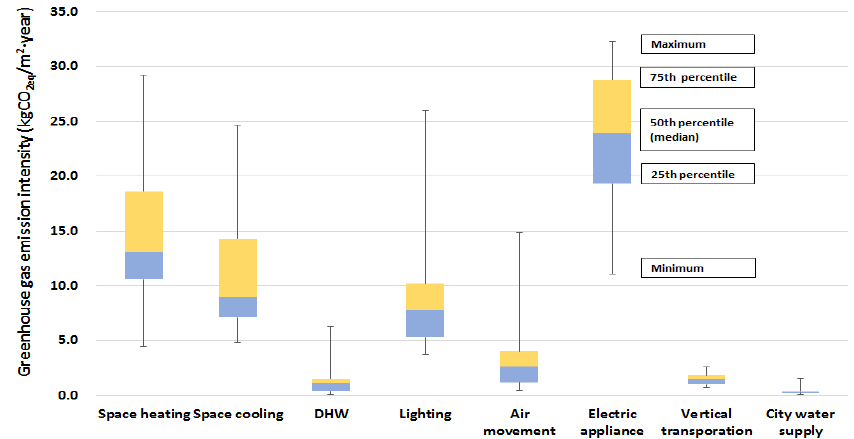
Figure A4. Box plot of greenhouse-gas-emission intensities by end-use (kgCO 2eq /m 2 ·year).